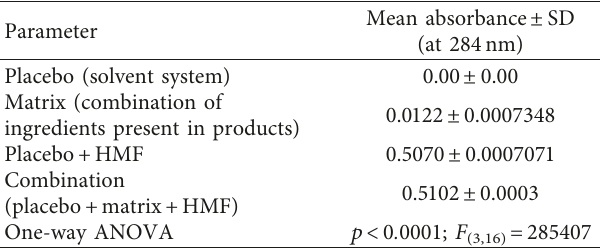
Figure 2: Mean absorbances ± SD ( N � 5) recorded under different test conditions, to prove specificity of the developed method. Table 1: Results of specificity test for 100% concentration of 5- HMF in matrices ( N � 5).